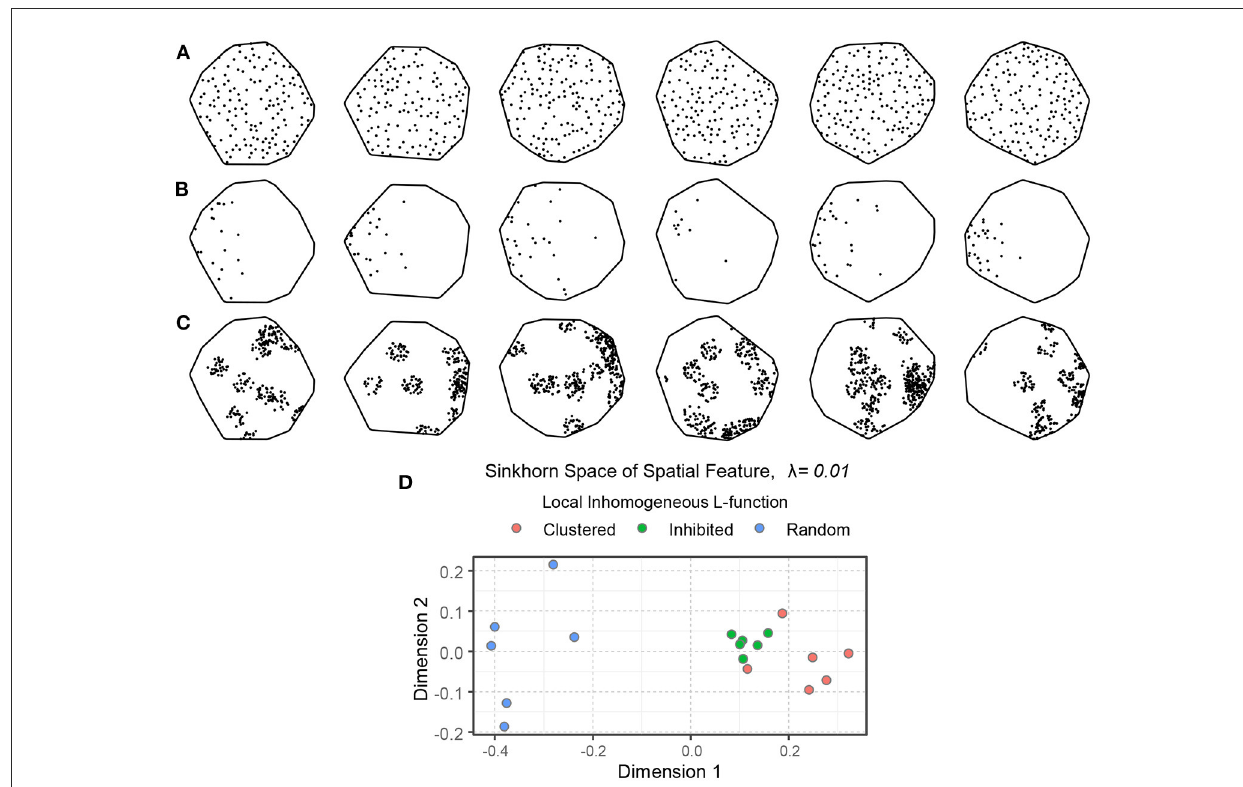
FIGURE7 An illustration of spatial point patterns with different inhomogeneous spatial interactions. (A) Spatial inhibition. (B) Spatial randomness. (C) Spatial clustering. The intensity functions of the random and clustered patterns introduce some anisotropy. (D) An embedding of the point patterns in the Sinkhorn space. The inhibited, random, and clustered point patterns are shown in green, blue, and orange,